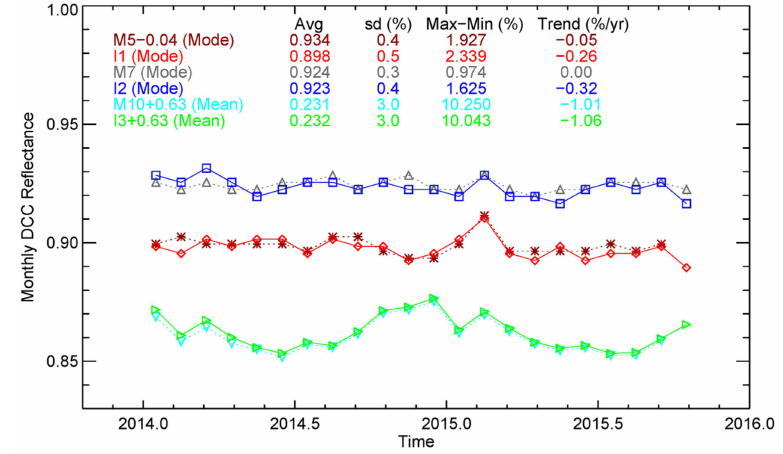
Figure 13. Monthly DCC time series for bands I1–I3 and their equivalent M-bands (ADM-adjusted monthly DCC reflectance mode time series were used for I1,I2, M5, and M7; monthly DCC TOA reflectance mean time series were used for I3 and